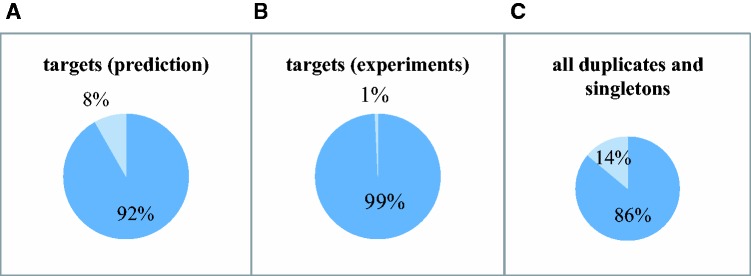
Duplicated genes are more likely to be targeted by miRNAs than singletons. The proportions of duplicates and singletons among all miRNA targets based on binding site prediction data set (A) and experimental data set (B) are indicated. The proportions of all duplicates and singletons in the genome are shown in (C). Lighter and darker portions of the pie charts represent singletons and duplicates, respectively.